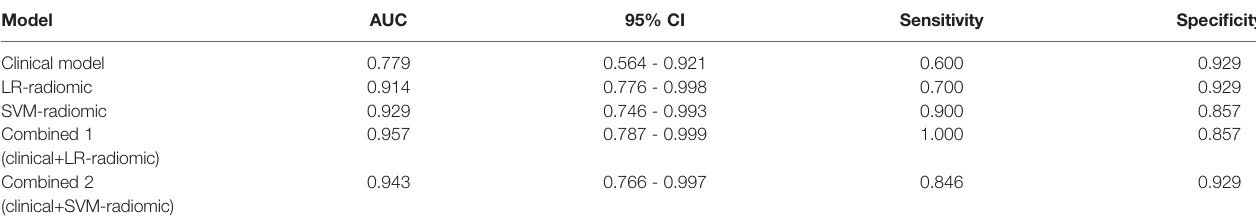
TABLE 13 | The ROC curve of clinical features, radiomic, clinical features + radiomic model in the validation cohort.